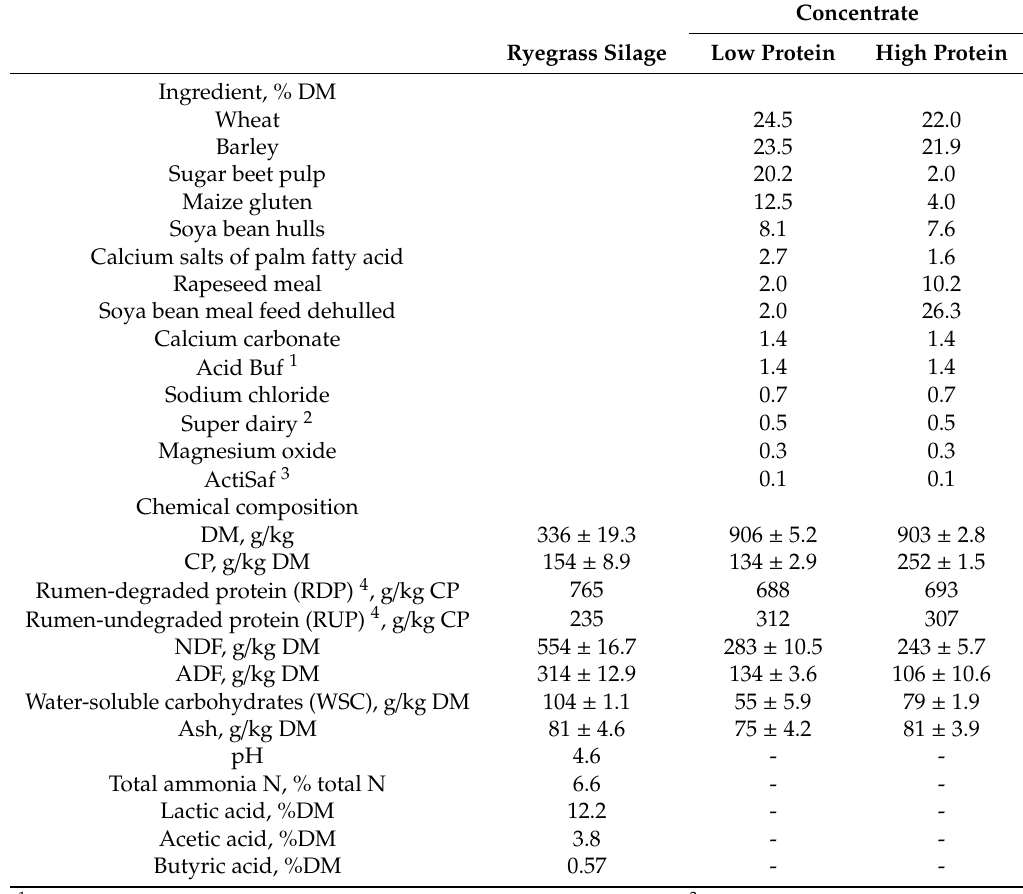
Table 1. Chemical composition of the silage and concentrates used. DM, dry matter; CP, crude protein; NDF, neutral detergent fiber; ADF, acid detergent